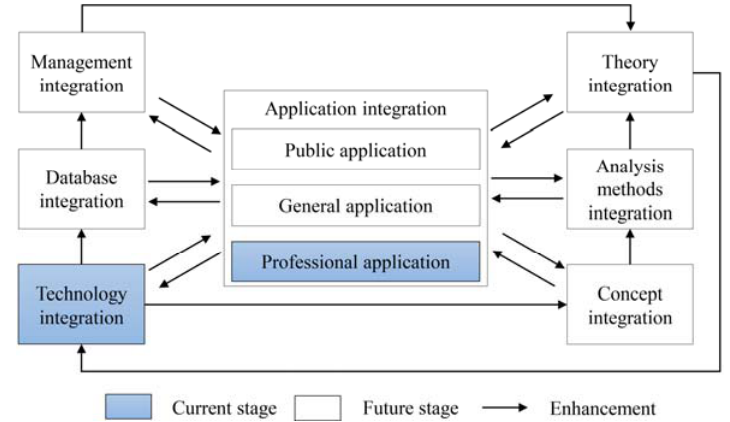
Figure 4. Relations among current and future evolution stages of BIM-GIS integration.